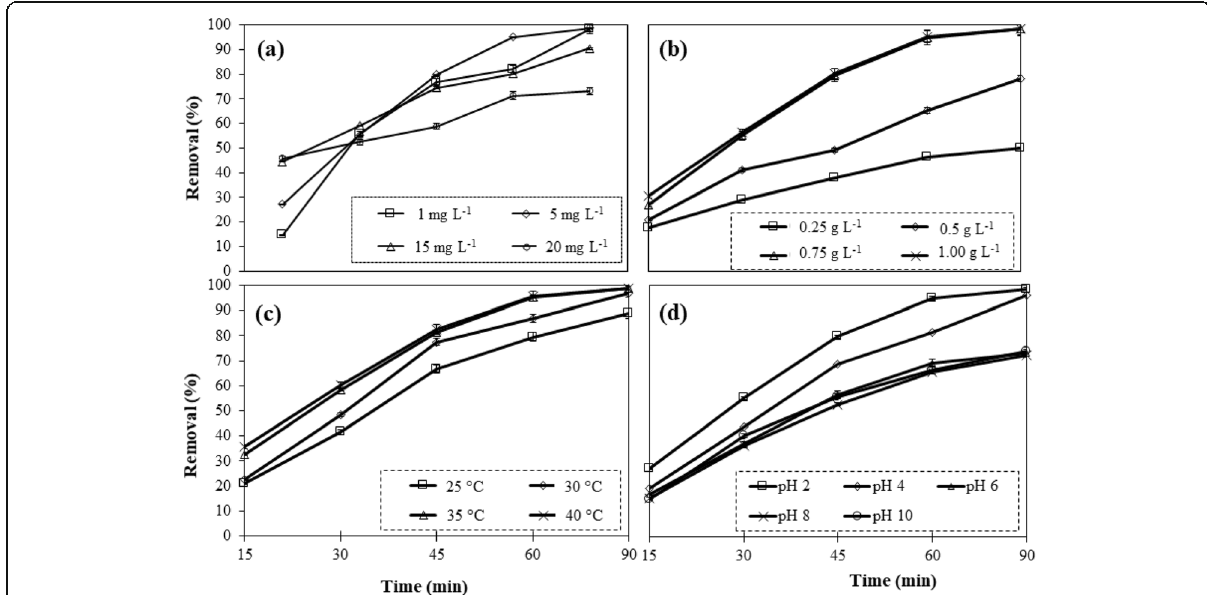
Fig. 3 Effect of experimental parameters on Carbamazepine (CBZ) adsorption over graphene oxide (GO). Plots ( a – d ) depict effect of variable initial CBZ concentration, GO dosage, experimental temperature and solution pH on rate of CBZ adsorption